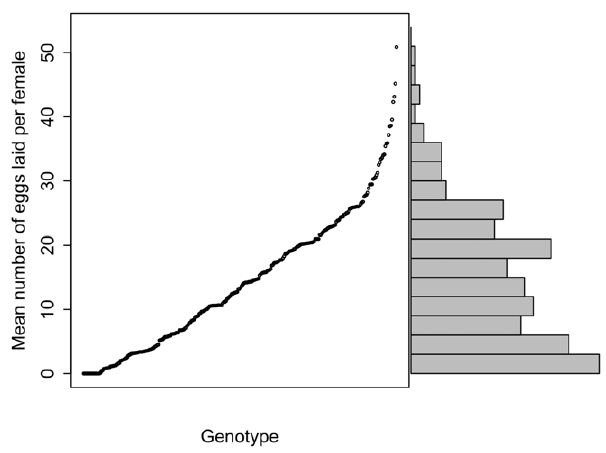
Figure 4. The average number of eggs laid for 282 inbred lines. Minimum sample size per line =5 females, mean =16.1 females. Variance and sample sizes vary considerably between genotypes (see text), and only means are shown for each genotype, for clarity. On the right, a histogram of the same data is shown.